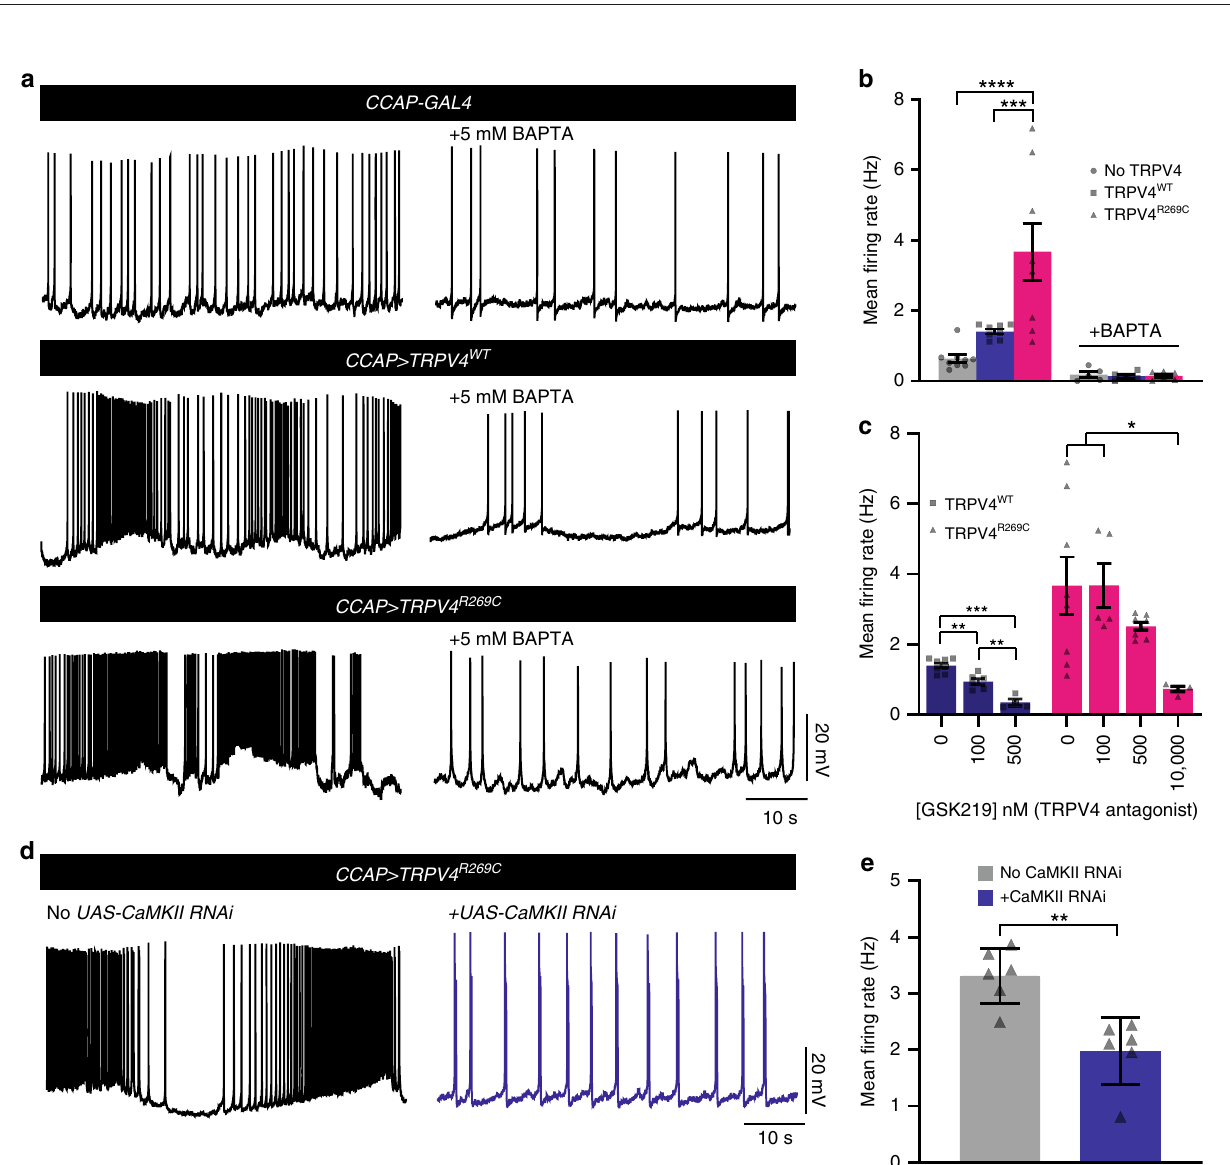
Fig. 3 CaMKII is required for TRPV4 R269C -mediated neuronal toxicity. a Histogram of results from genetic modi fi er screen against TRPV4 R269C toxicity in N CCAP . Dashed magenta lines denote upper and lower bounds of control lines. b Images of fl ies expressing TRPV4 R269C (mod) ± CaMKII RNAi. c Percentage ± 95% CI of fl ies with unexpanded wings when co-expressing TRPV4 R269C (mod) and different CaMKII RNAi fl y lines. A = TRiP collection lines, B = Vienna GD collection lines, and C = Vienna KK collection lines. From left to right n = 65, 59, 60, 25, 65, 66, and 90 fl ies. Χ 2 test of all groups ( p < 0.0001) followed by pairwise two-sided Fisher ’ s exact test. d Confocal stacks of axonal projections in C4da neurons expressing TRPV4 R269C (high) ± CaMKII RNAi. e Mean ± SEM innervation in d . n = 5, 4, and 5 larvae, respectively. One-way ANOVA ( p < 0.0002), Tukey ’ s post hoc test. Scale bar, 25 µ m. f Climbing performance of fl ies 7 days after induction of expression of TRPV4 R269C (high) ± CaMKII RNAi with 200 μ M RU486. Mean ± SEM. n = 10 vials of 10 fl ies per genotype. Two-way ANOVA ( p < 0.0001), Tukey ’ s post hoc test. g Percentage ± 95% CI of fl ies with unexpanded wings when co-expressing TRPV4 R269C (low) with variants of CaMKII. T287D 1 and T287D 2 denote independent UAS - CaMKII T287D lines. From left to right n = 63, 55, 68, 44, 23, 33, 28, 23, 2, and 3 fl ies. Χ 2 test of all groups ( p < 0.0001) followed by pairwise two-sided Fisher ’ s exact test. For all panels: ** p < 0.01, **** p